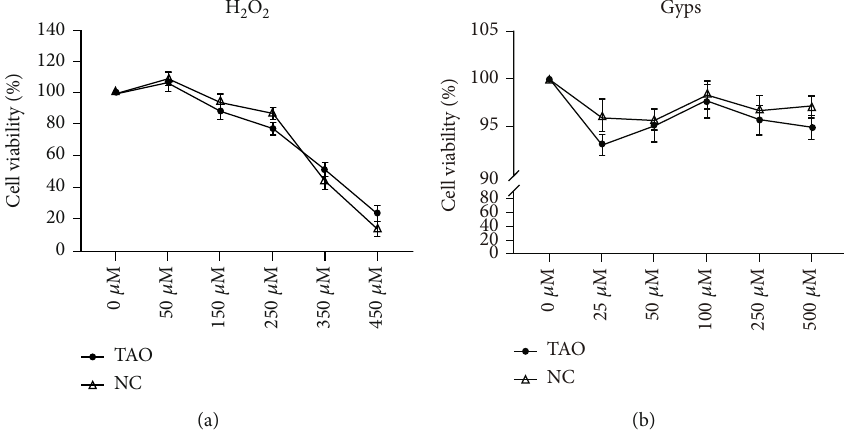
Figure 5: E ff ects of H O and gypenosides on the viability of orbital fi broblasts in patients with GO and non-GO. (a) Treating OFs in GO 2 2 and non-GO patients with 350 μ M H O for 24 hours can achieve 50% viability of cells, which is an appropriate concentration to establish 2 2 apoptosis model. (b) Treating OFs of GO and non-GO patients with 100 μ g/mL Gyps for 48 hours can reach the maximum cell viability and not exceed the intervention concentration of the control